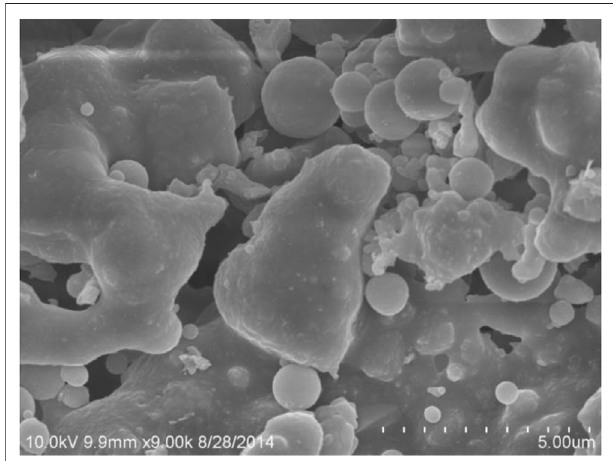
FIGURE 1 | Scanning electron micrograph of coal fl y ash.